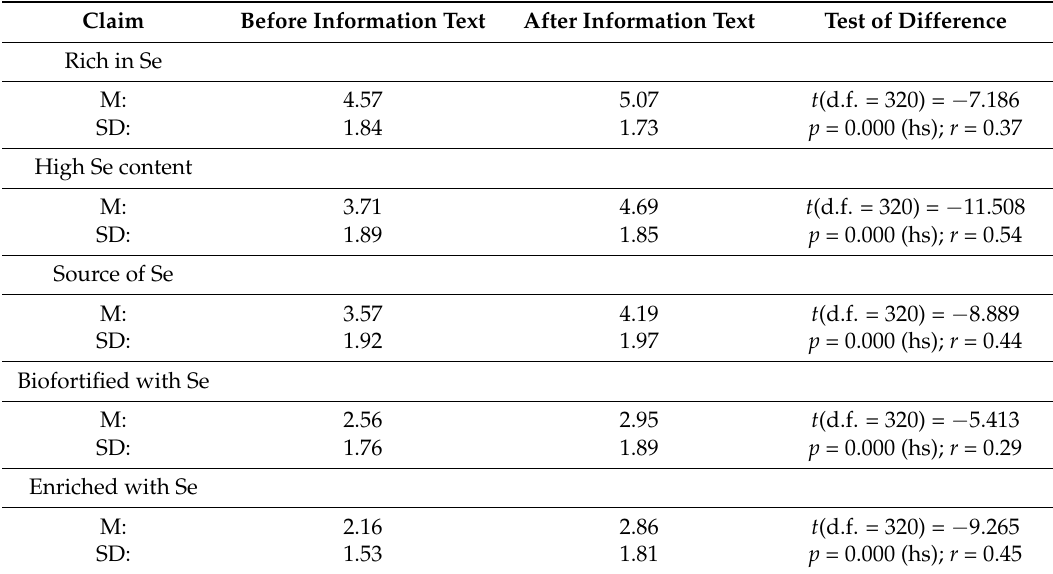
Table 4. Effect of explanatory information on consumer acceptance of Se-related nutrition claims used for apples.